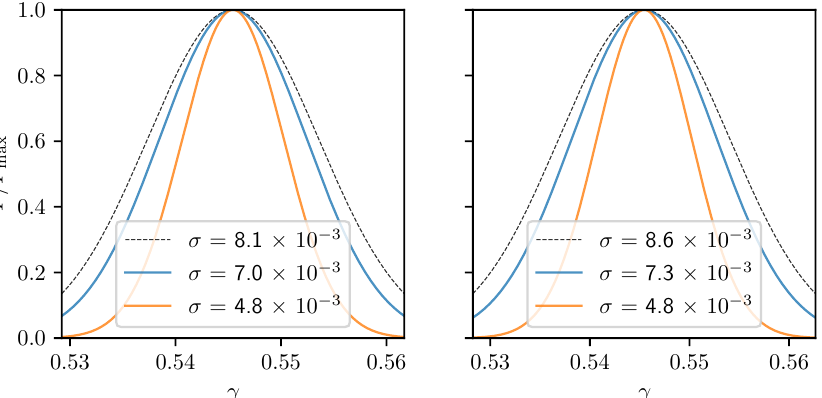
Figure 8. 1D posterior distribution for the γ parameter for Euclid alone (black), and adding CMB lensing (blue) and all CMB observables (orange). The CMB data here are taken to be SO-like. The left panel refers to a flat w 0 w a γ CDM cosmology, while the right one drops the flatness assumption. This figure is taken from in